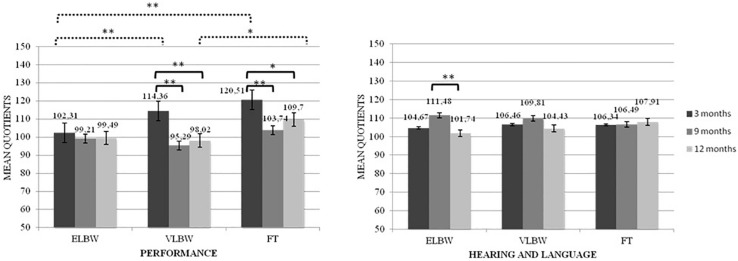
Performance and Healing and Language quotients according to the interaction between birth weight and time of assessment. *p < 05; **p < 0.005. Continue line denotes within group comparison; dotted line between group comparison.